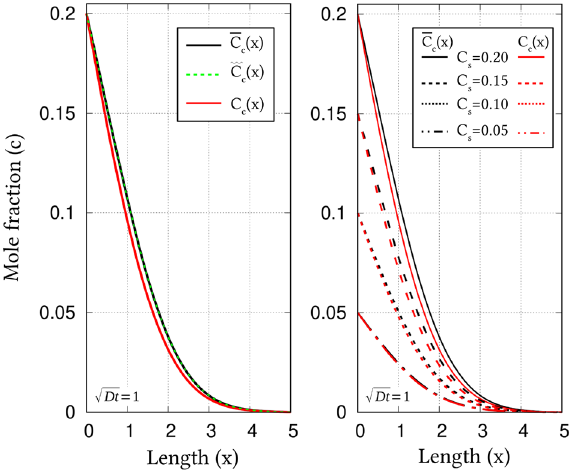
1 , reflecting the diffusion governed by mole- and Figure 2. Concentration profile of carbon, at √ Dt = site-fraction based formulations, respectively expressed in Eqs. (53) and (55). On the left plot, wherein single surface-concentration is treated, concentration profile for a different ratio-constant, a (cid:31) , is included. Concentration profile emerging from various surface-contents is graphically represented on the